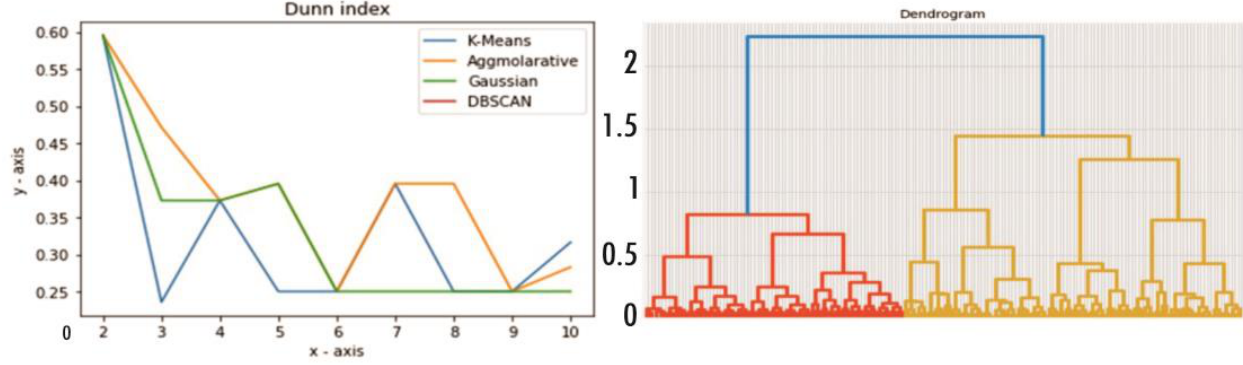
Figure 3. Dunn index and dendrogram for different algorithms at different cluster number.